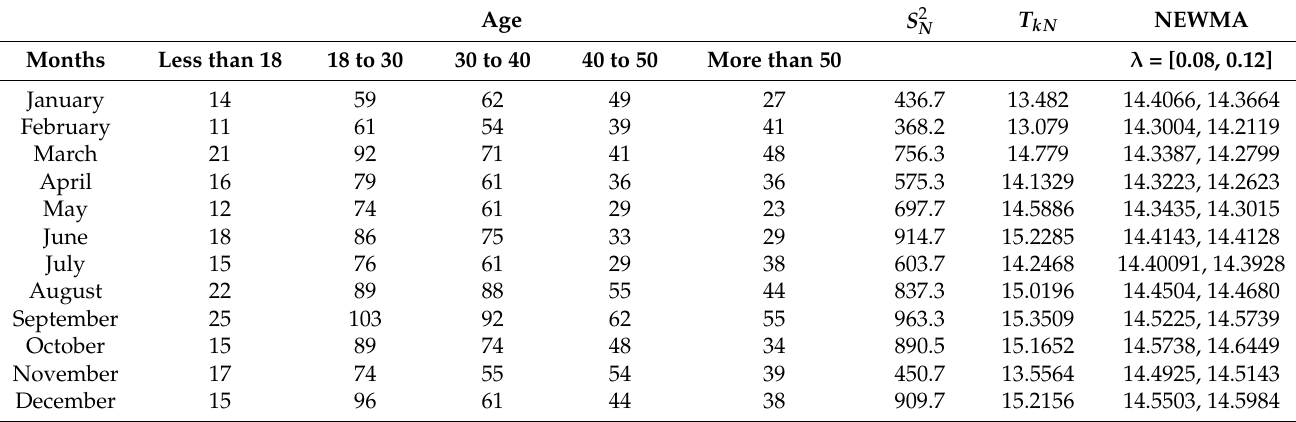
Table 8. The calculations of the statistic of (cid:1846) (cid:3038)(cid:3015) ∈ [(cid:1846) (cid:3038)(cid:3013) , (cid:1846) (cid:3038)(cid:3022) ],(cid:1852) (cid:3038)(cid:3015) ∈ [(cid:1852) (cid:3038)(cid:3013) , (cid:1852) (cid:3038)(cid:3022) ] when (cid:1866) (cid:3015) ∈ Table 8. Real data related to Injury Data of Table 8. Real data related to Injury Data of Jeddah.